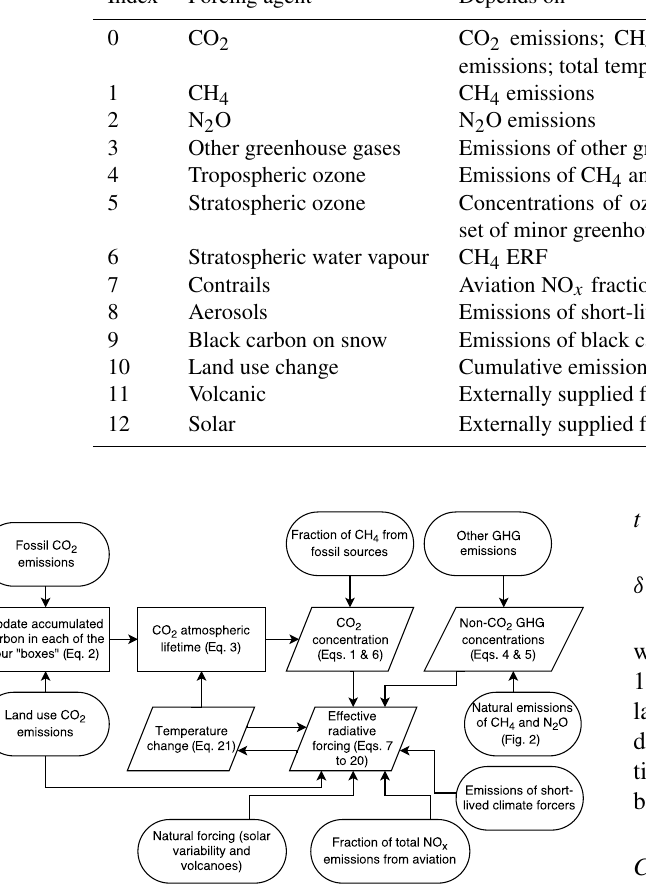
Figure 1. Simplified overview of the FAIR v1.3